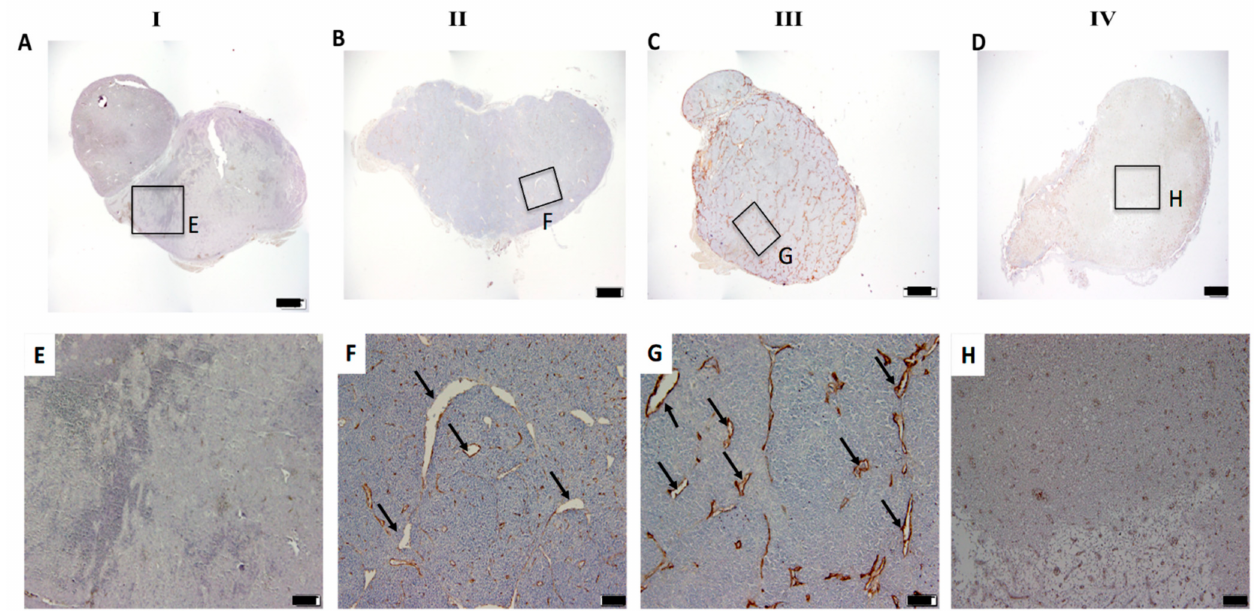
Figure 4. Histological analysis of PALN for anti-tumour effects. Representative section showing immunostaining with anti-CD31 antibody in the whole PALNs of ( A ) control group with PBS only, ( B ) control group with PAuNRs only, ( C ) group with PBS + laser and ( D ) group with PAuNRs + laser after treatment. Scale bars: 200 µ m. Magnified view of ( E ) control group with PBS only, ( F ) control group with PAuNRs only, ( G ) group with PBS + laser and ( H ) group with PAuNRs + laser after treatment that is outlined in boxes. Scale bars: 100 µ m; I, control group with PBS only; II, control group with PAuNRs only; III, group with PBS + laser; IV, group with PAuNRs + laser; black arrows pointing at the open